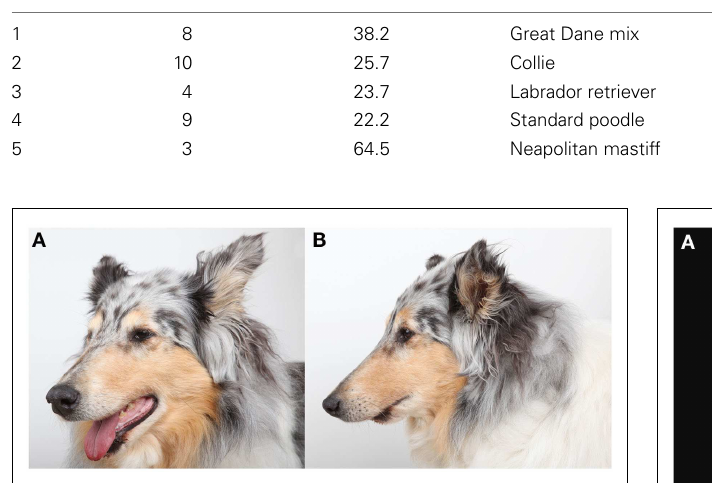
FIGURE 3 | Photographs of dog 2 at 6months recheck illustrating the appearance of the mandibles and skull following successful reconstruction of the rostral mandibles .